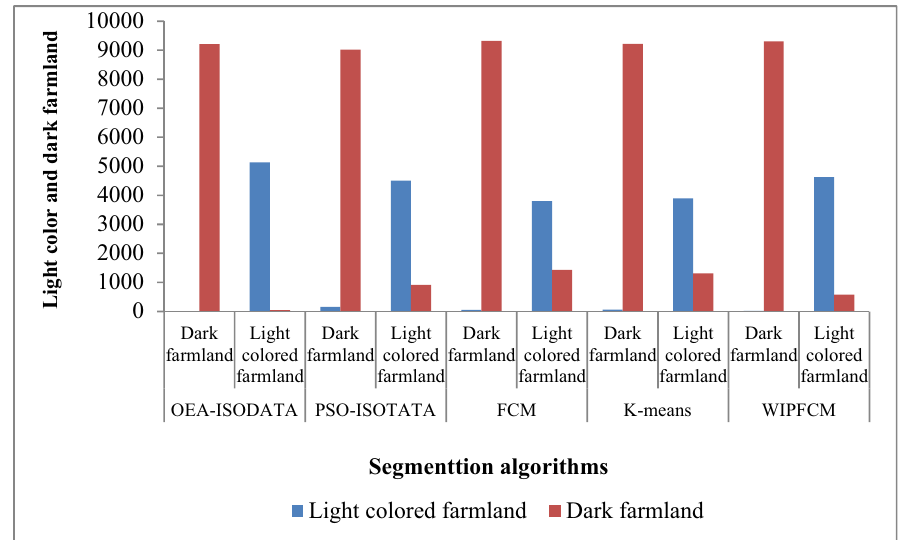
Figure 5: Segmentation results of di ff erent algorithms for farmland SAR